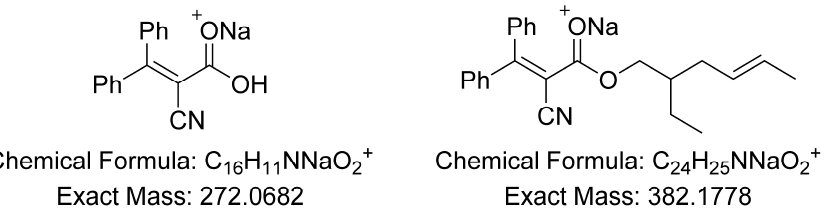
Figure 1. OC–fatty acid conjugates common products in collision-induced fragmentation of sodiated molecular ions.